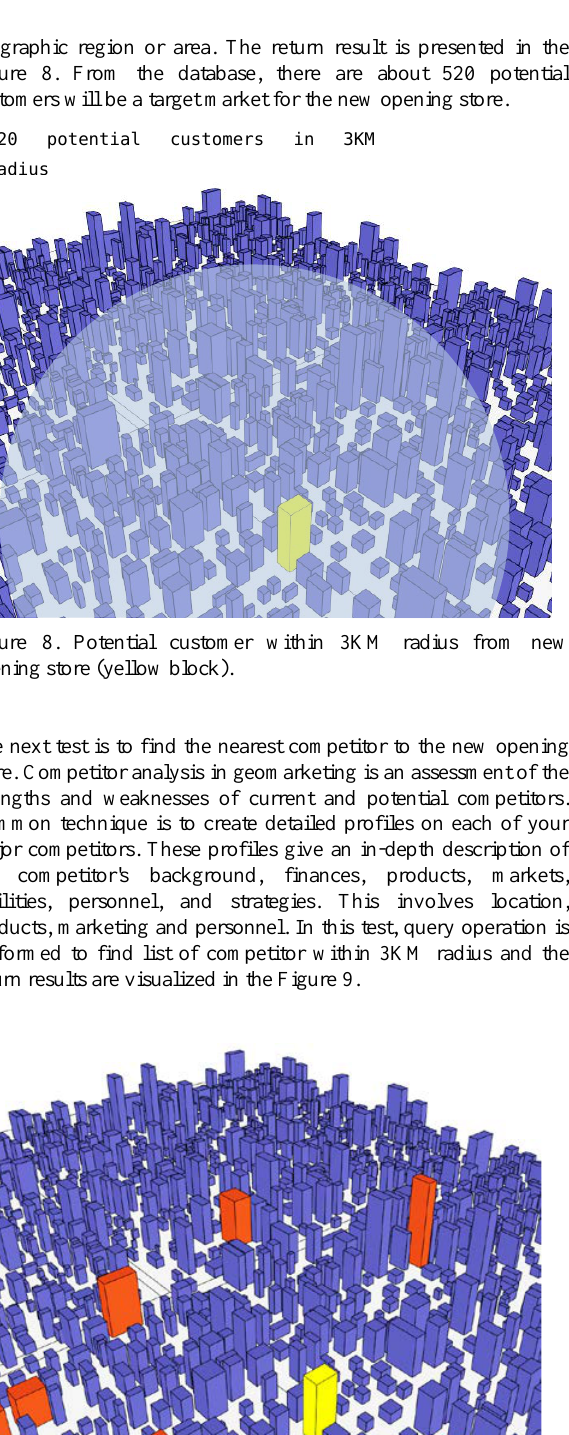
Figure 8. From the database, there are about 520 potential customers will be a target market for the new opening store.